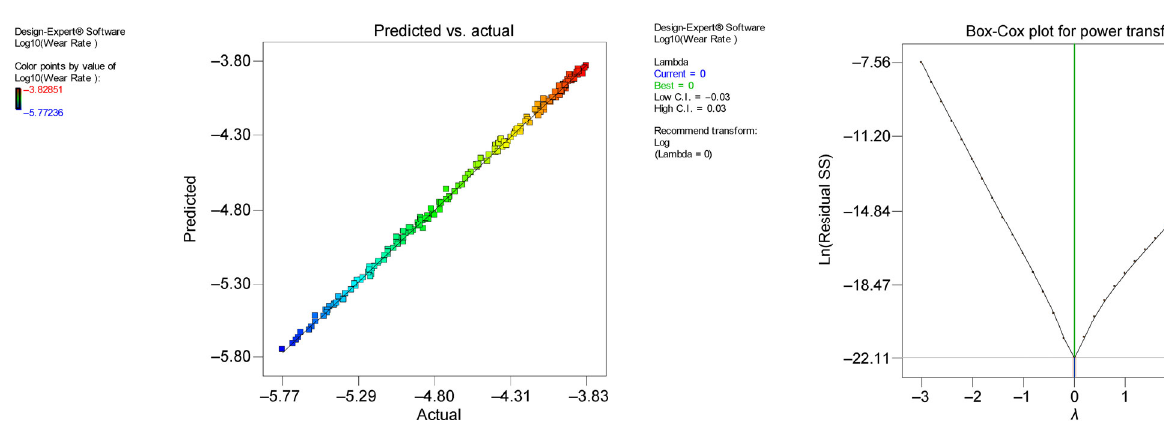
Fig. 6 Predicted versus actual response values for W R . Fig. 7 Box-Cox plot for power transformation in the case of W R